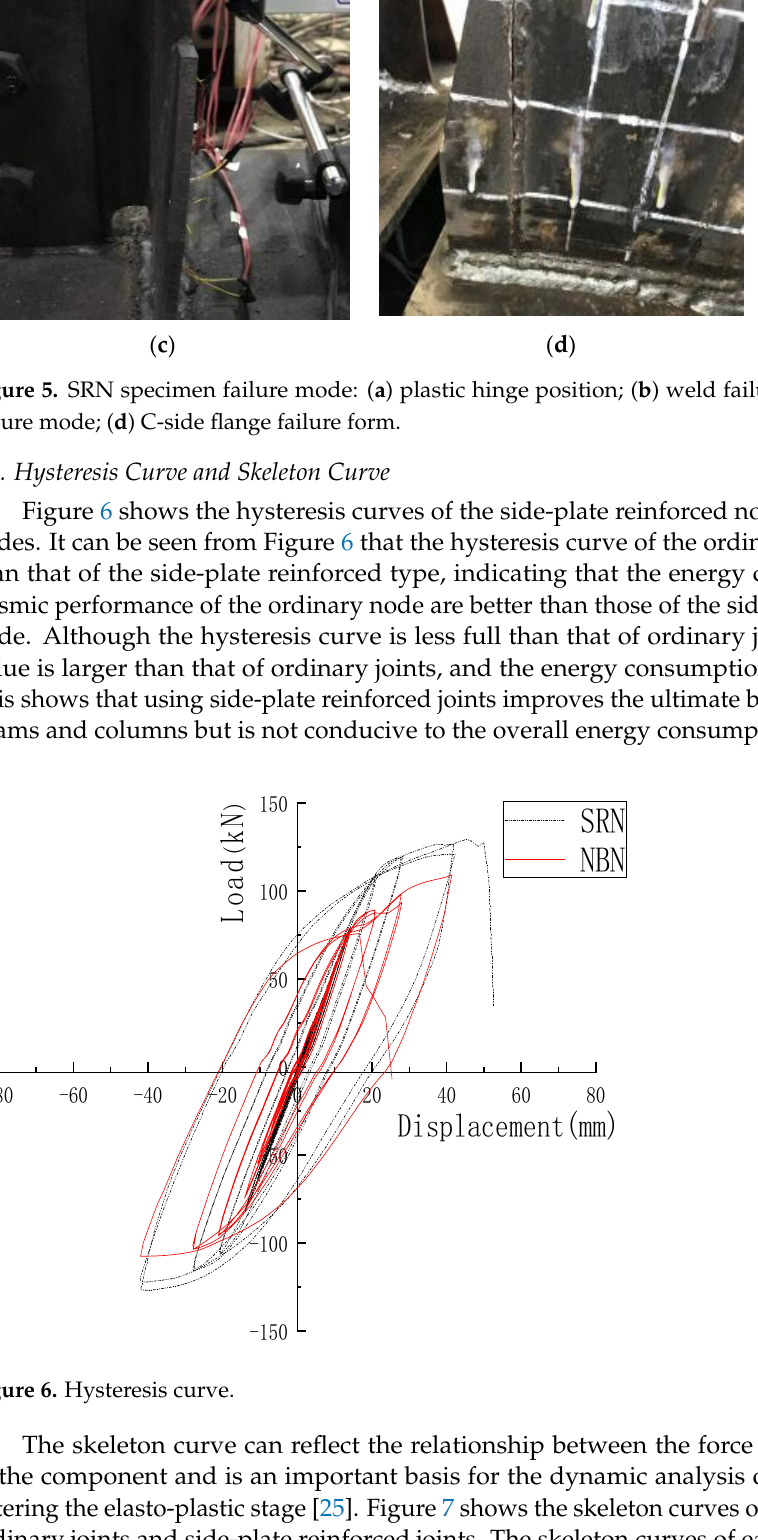
Figure 7. The skeleton curves . 3.3. Ductility Table 2 shows the specimens’ characteristic point load, displacement, and displace- ment ductility coefficients [3]. The experimental data show that the same specimen’s pos- itive and negative ductility coefficients are not significantly different. Nonetheless, the average value of the two represents the ductility of the side-plate reinforced joint. The coefficient was 23.6% higher than that of ordinary joints, which shows that side-plate re- inforced joints have better ductility performance than ordinary joints. The energy dissipation performance of the structure can be used to evaluate the struc- ture’s seismic performance, and the energy dissipation capacity of the steel frame joints can be measured by the equivalent viscous damping coefficient (h e ) [26,27]. The equiva- lent viscous damping coefficient can be obtained according to the area SABCOA and the S △ BOD ratio of the area enclosed by the hysteresis curve ABC and the horizontal axis, as shown in Figure 8. The He of SRN and NBN are 0.306 and 0.290, respectively, indicating that the area of the hysteretic curve of the side-plate reinforced node is larger and fuller. Therefore, the side-plate reinforced node has a strong energy consumption capacity.